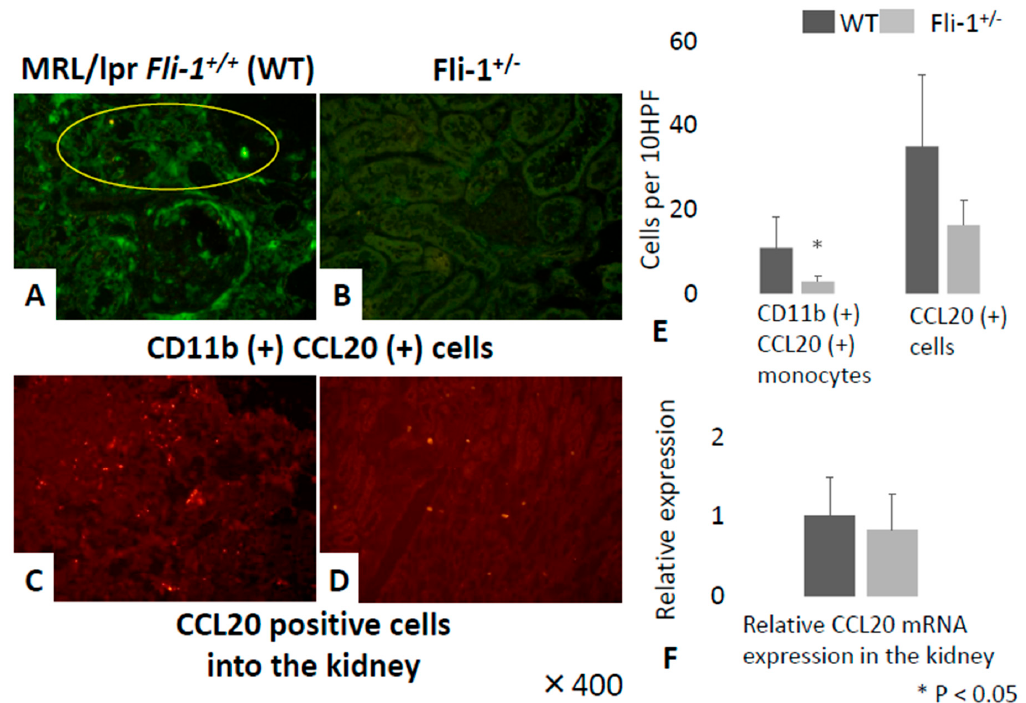
Figure 6. Detection of CD11b + CCL20 + immune cells and infiltration of CCL20 positive cells in the kidney of MRL/lpr Fli-1 +/+ (WT) and MRL/lpr Fli-1 +/ − mice using FITC-conjugated anti-CD11b and Alexa Fluor 647-labeled anti-CCL20 antibodies. Detection of CD11b + CCL20 + immune cells ( A , B ) and infiltration of CCL20 positive cells ( C , D ) in the kidney of both groups are shown; total counts from ten random high-power fields (HPFs) ( E ) ( n = 6–7 per groups). Relative expression of transcript encoding CCL20 in the two groups ( n = 3–4 per groups) ( F ) is shown; * p < 0.05 is considered as significant.